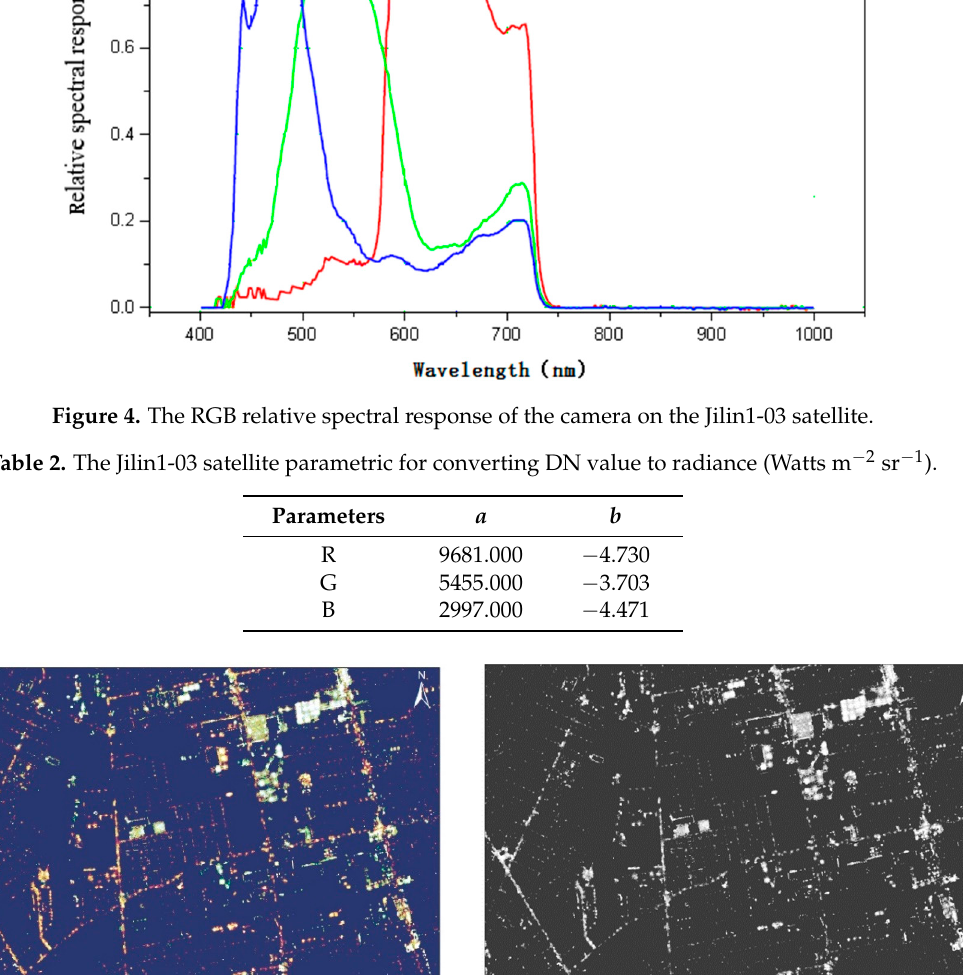
Figure5. The Jilin1-03 satellite night-time image with (a) RGB bands and the (b) grayscale